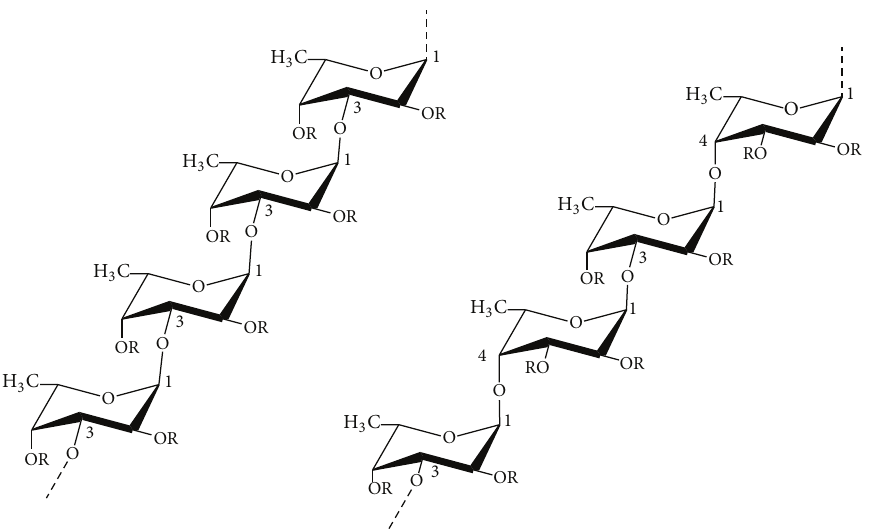
Figure 1: Two different types of homofucose backbone chains in fucoidans isolated from brown seaweed. R groups depict the potential places for attachment of noncarbohydrate (sulfate and acetyl groups) and carbohydrate ( 𝛼 -l-fucopyranose and 𝛼 -d-glucuronic acid)